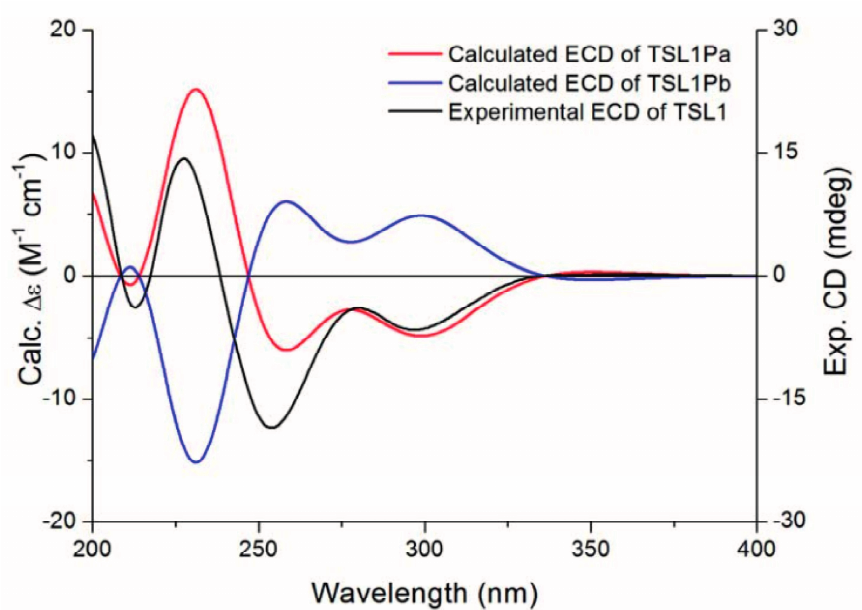
Figure 3. Experimental solution spectrum (black) of salvianolic acid Y (TSL 1) compared with the calculated ECD spectra of (2 R ,3 S )-TSL 1Pa (red) and (2 S ,3 R )-TSL 1Pb